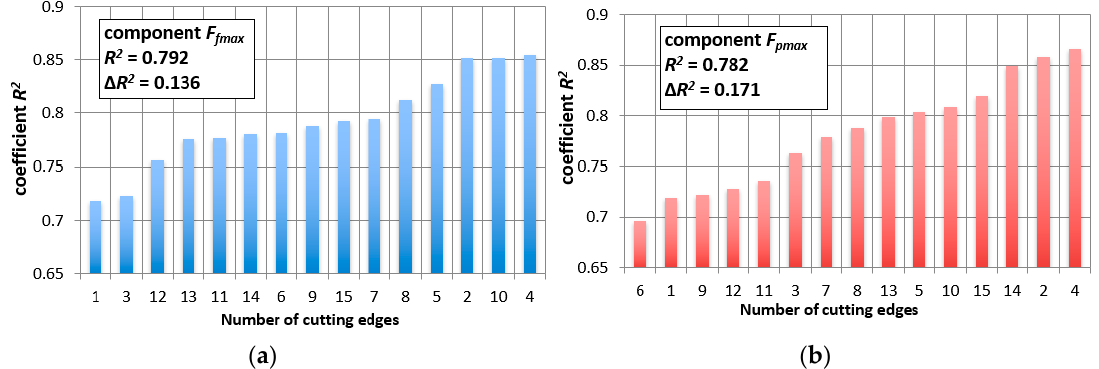
Figure 3. Feed force, Ff_max, as a function of flank wear, VBc , for all 15 cutting wedges.